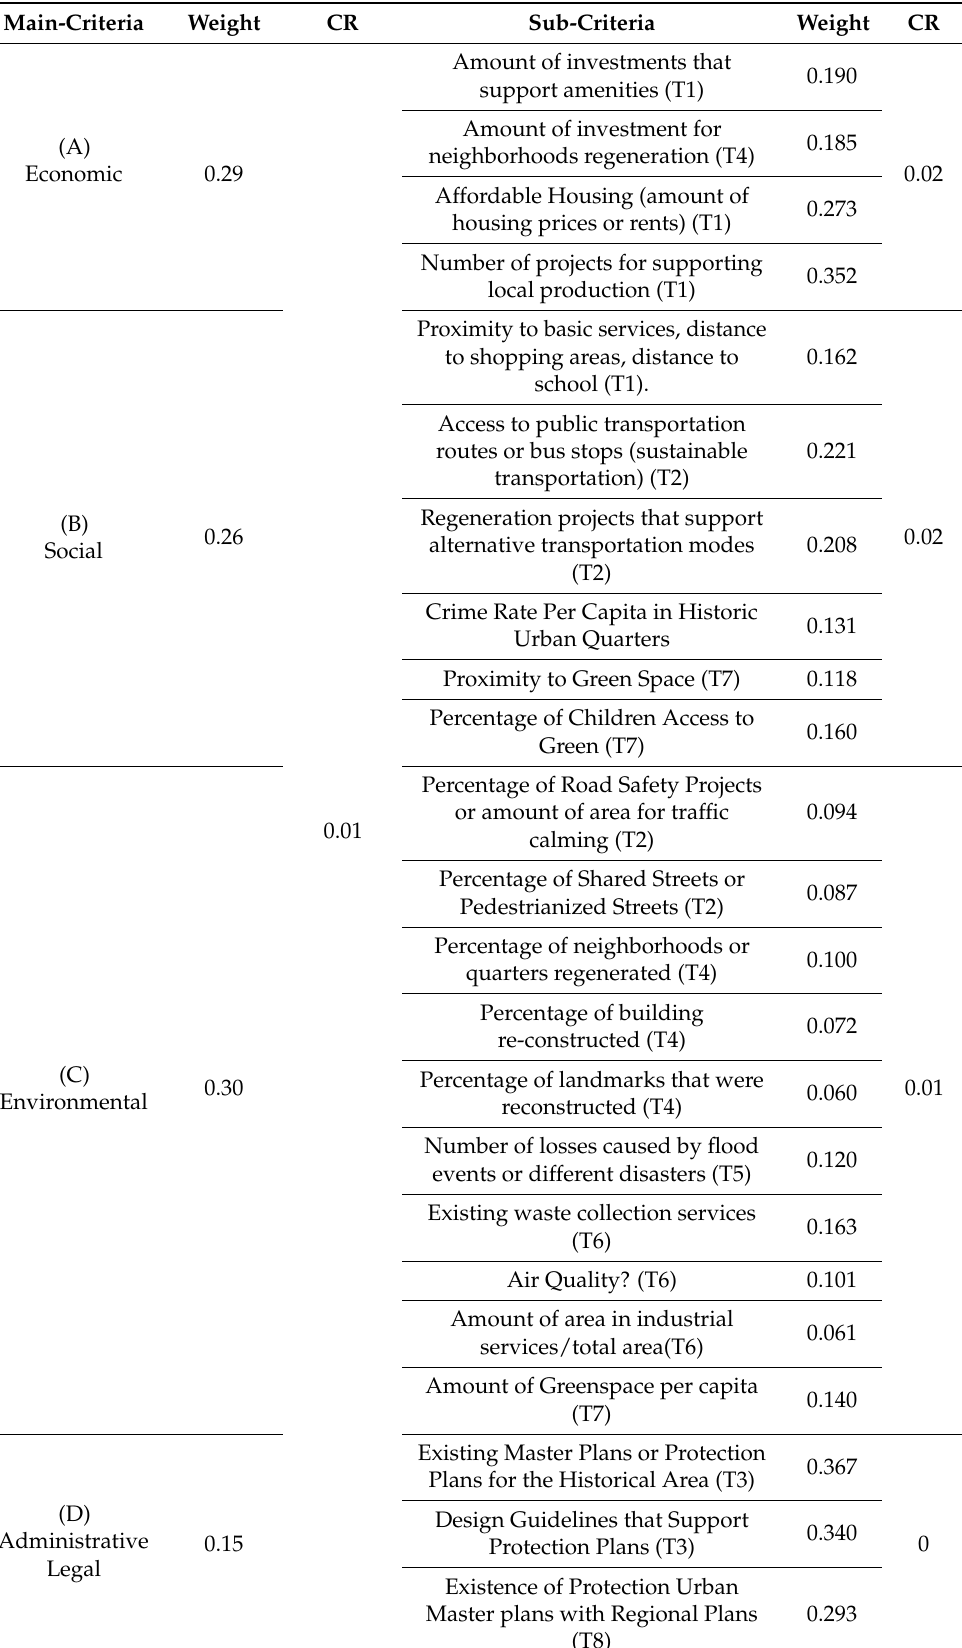
Table 1. Comparison and weight results for the selected criteria